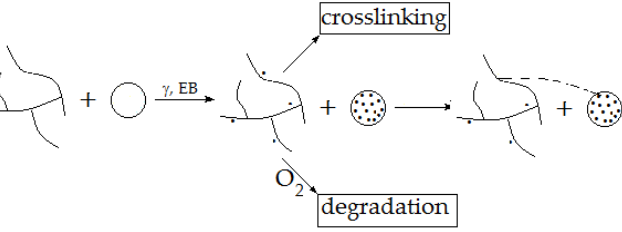
Figure 2. Summary scheme for the formation of bridges between the polymer phase and nanoparticle that convert polymer composites into hybrid materials.